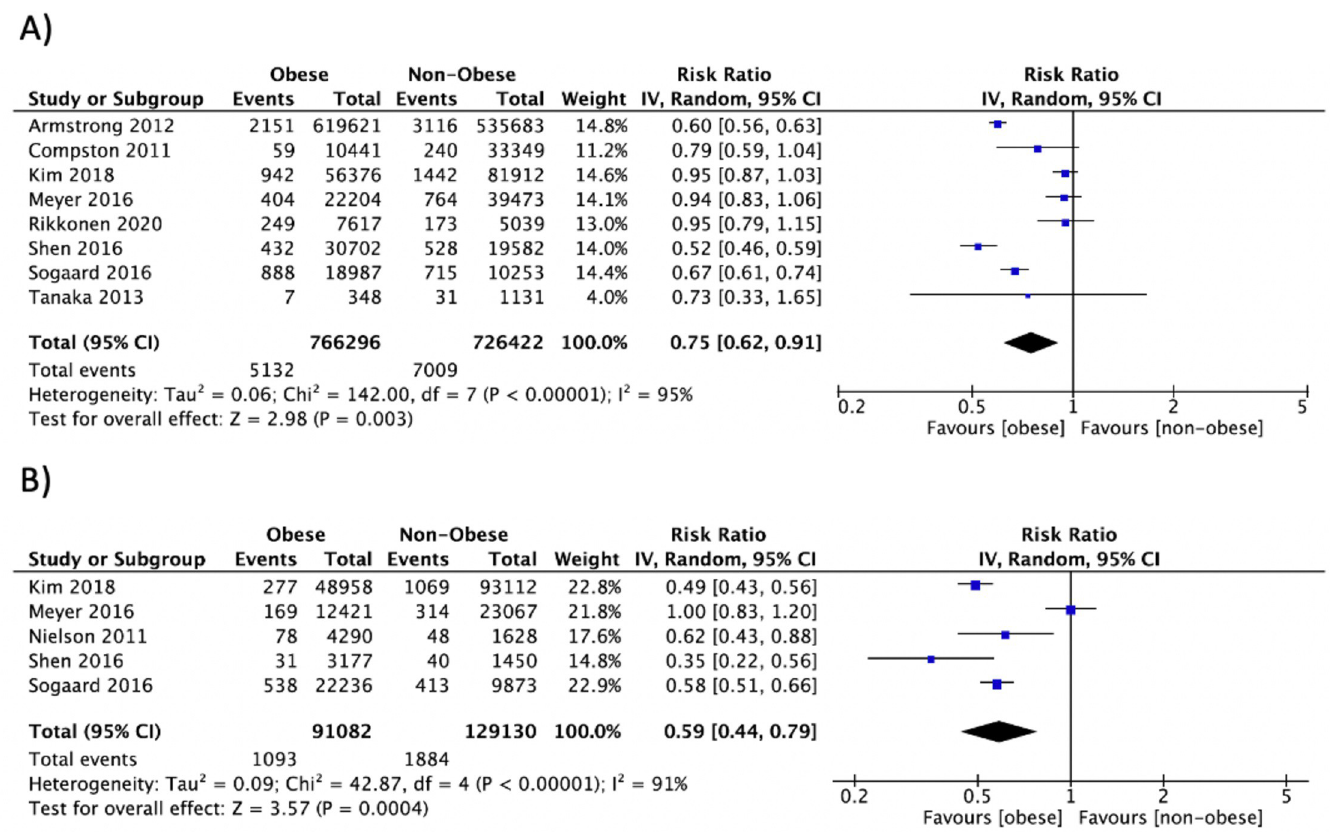
Fig 3. Forest plot of pooled effect size for the risk of hip fracture in A) postmenopausal women and B) men with vs. without obesity, using a random-effect model.